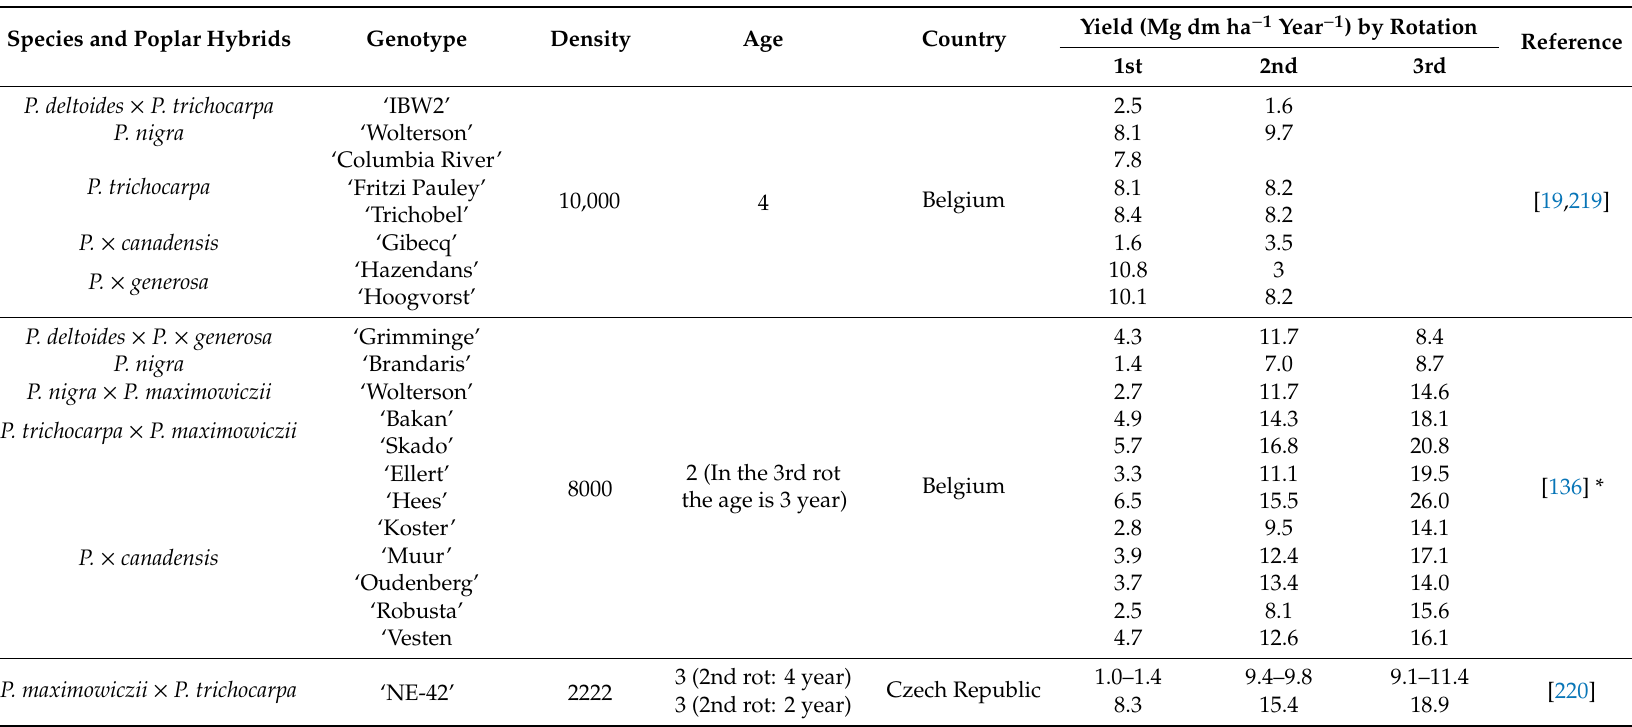
Table 2. Di ff erent examples of the biomass yield (Mg dm ha − 1 year − 1 ) per genotype, age, and rotation in poplar short rotation plantations in Europe (excluding